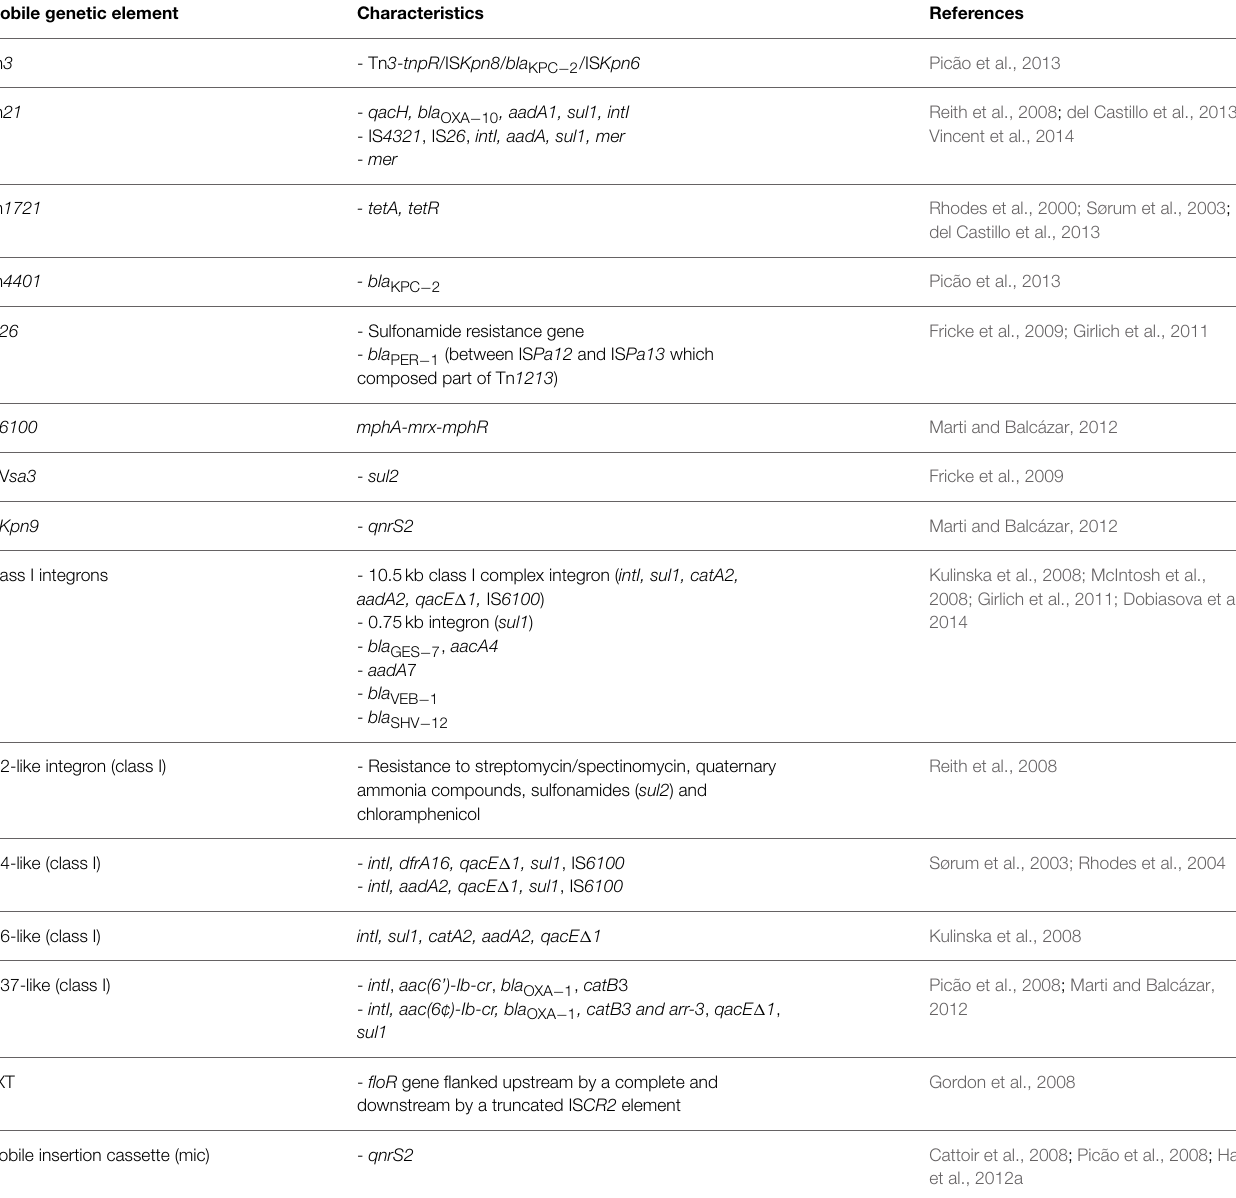
TABLE 2 | Other than plasmid borne mobile genetic elements of Aeromonas spp. Mobile genetic element